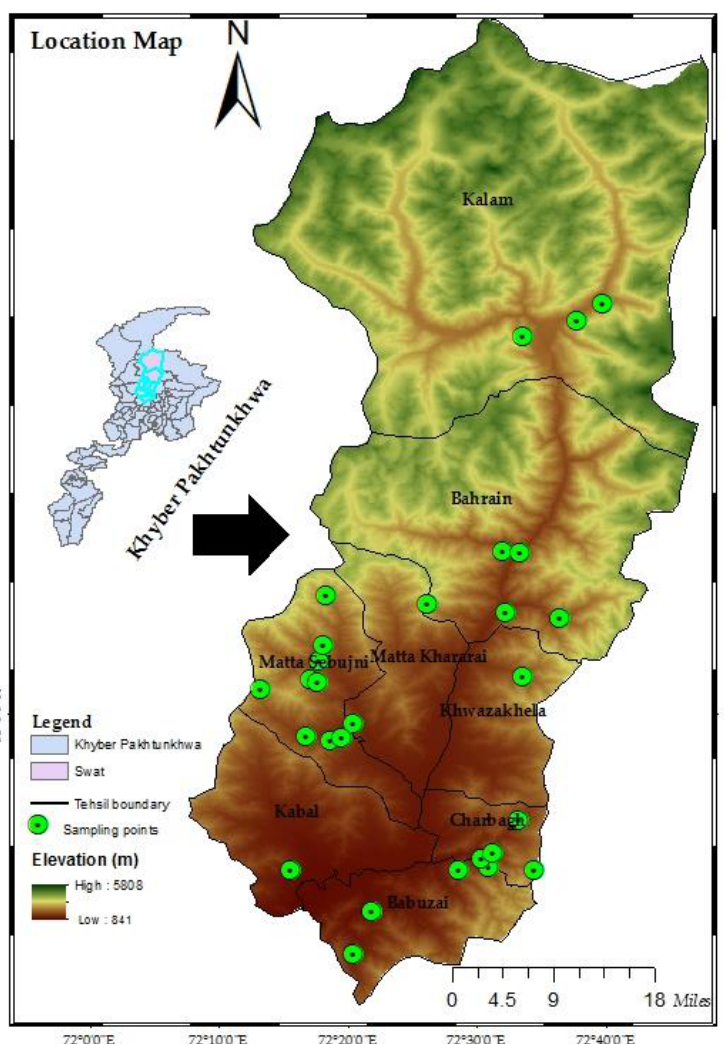
Figure 1. Showing sampling points in oak-dominated forests of Swat, Pakistan.